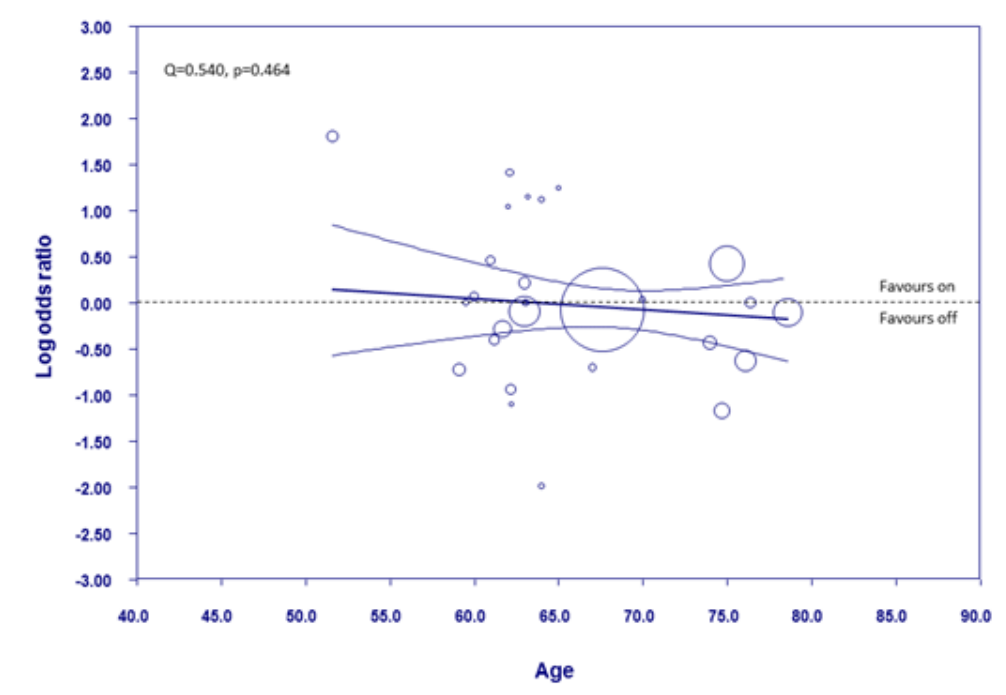
Fig. 7 – Weighted random-effects meta-regression analysis regressing the log odds ratio of myocardial infarction against age in the off- pump group. All other details as in Figure